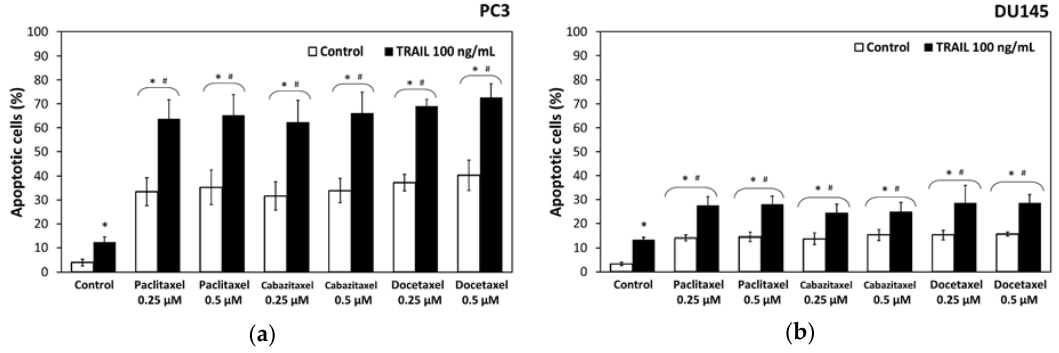
Figure 2. Apoptotic effect of TRAIL (100 ng/mL) in combination with paclitaxel, cabazitaxel